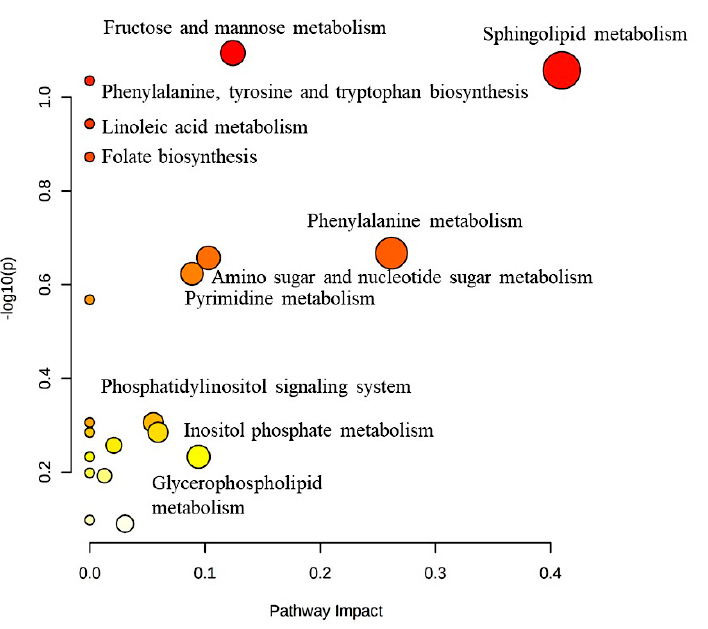
Figure 6. Pathway analysis for the significant metabolites dysregulated in MDA-MB-231 cells treated with the E. coli secretome. In total, 105 metabolites were ultimately identified as human endogenous metabolites, where 53 and 52 were up- and downregulated after 24 h of treatment with the E. coli secretome.